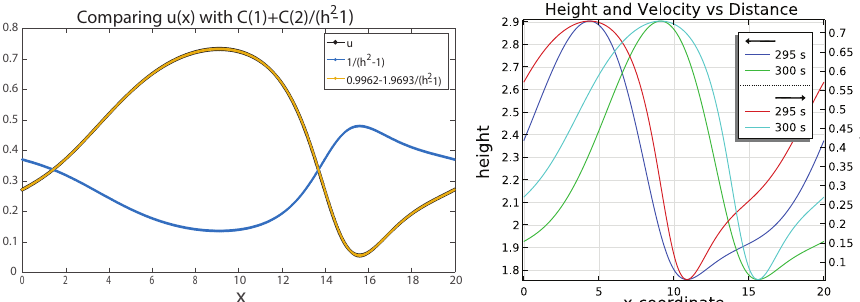
Figure 10. The plots on the left illustrate the perfect fit obtained when u ( x ) is fit to a function of the form C 1 + C 2 / ( h ( x ) 2 − 1 ) . The blue curve shows 1/ ( h 2 − 1 ) while the other curve shows u ( x ) and its best fit that appear superposed. The plots on the right show the height and velocity profiles at two different times and confirm that the traveling wave speed V is matched with high